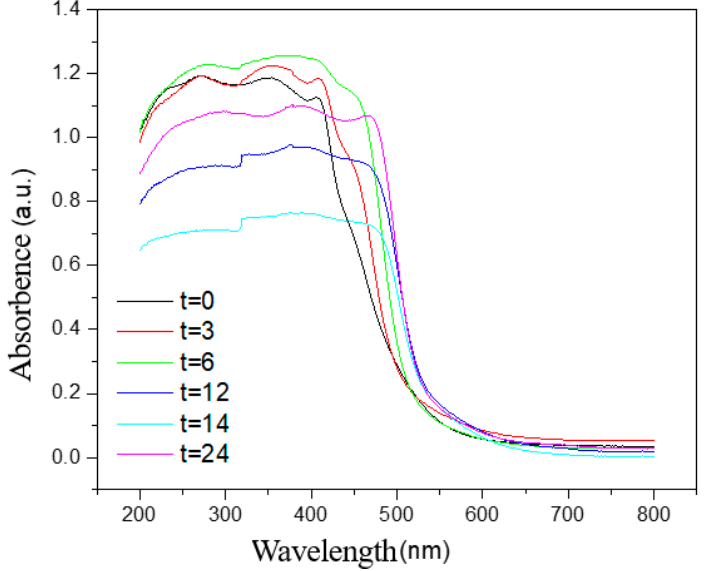
Figure 3. UV-Vis spectra of the BiVO 4 under the different hydrothermal time conditions.